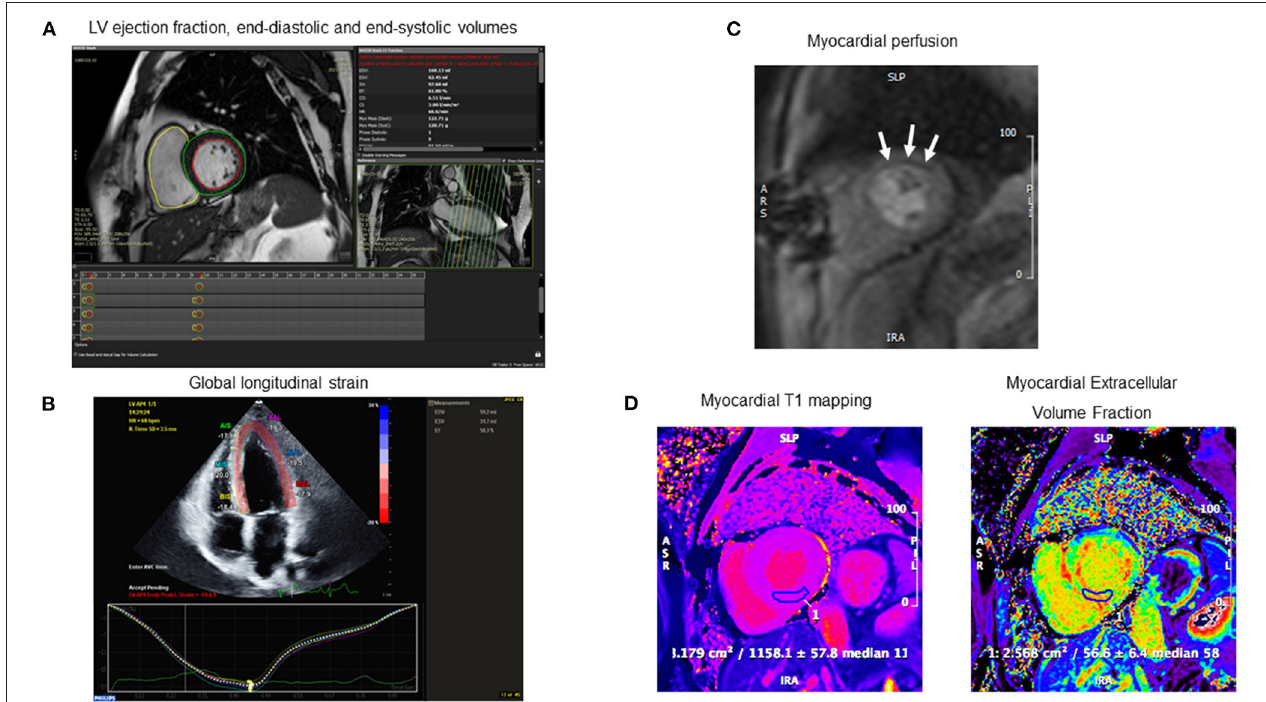
FIGURE 1 | Examples of cardiac imaging metrics to assess the effects of exercise training in patients with or at risk for cardiovascular disease. (A) Left ventricular volumetric analysis of short-axis steady state free precession (SSFP) images acquired from cardiac MRI. (B) Global longitudinal strain acquired transthoracic echocardiogram. (C) Myocardial perfusion acquired from first-pass gadolinium enhanced imaging on vasodilator stress cardiac MRI. Note anterolateral perfusion defect (white arrows). (D) Myocardial tissue characterization on cardiac MRI with native T1 mapping (left) and extracellular volume fraction (ECV) (right). Note the elevated myocardial T1 (1,158ms) and ECV (57%) consistent with cardiac